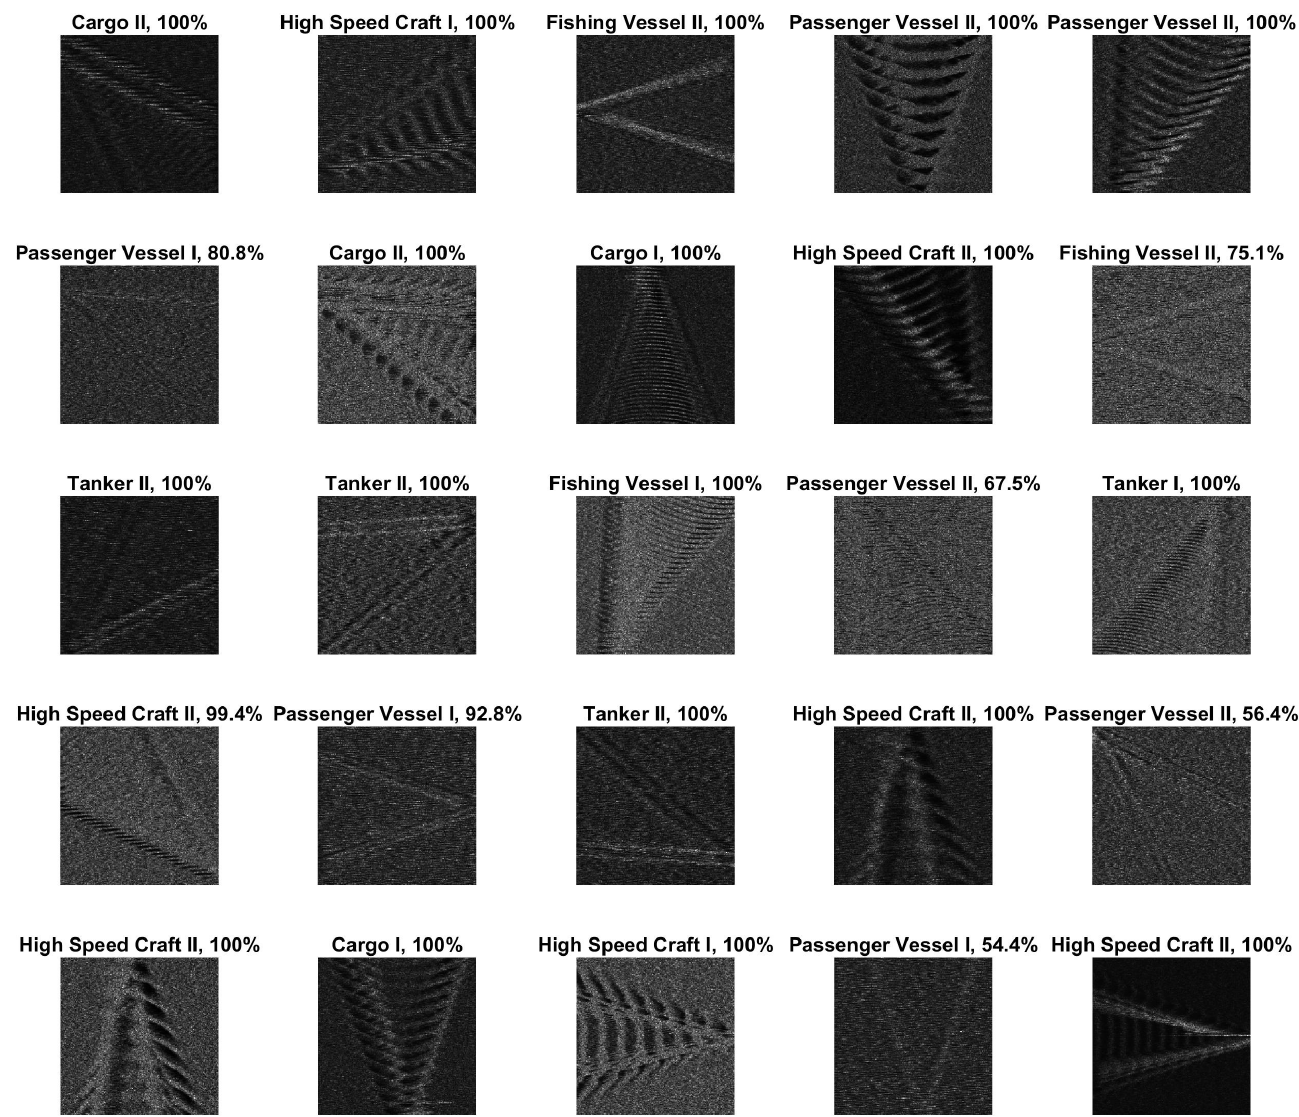
Figure 5. Randomly selected test images ( I n -Net: I n ) with predicted classes and their pre- dicted